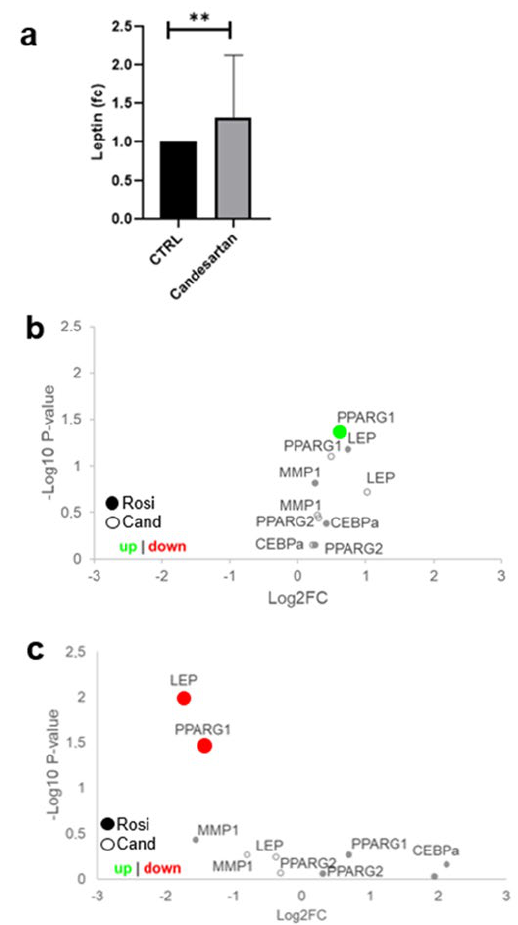
Figure 2. Leptin secretion is upregulated by candesartan in placental explants. ( a ) First-trimester placental villous explants were cultured for 24 h in 0.1 µM candesartan (Cand) and control conditions ( n = 8, isovolumetric control with DMSO). Leptin concentrations were upregulated 1.5-fold (one-sample t -test, p = 0.0025). ( b ) SGHPL-4 cells were treated with 5 µM rosiglitazone or 1 µM candesartan. In qPCR, PPARG1 was upregulated in rosiglitazone-treated cells ( n = 3, Kruskal–Wallis p = 0.0210). ( c ) BeWo cells were treated with 5 µM rosiglitazone (Rosi) or 1 µM candesartan (Cand) for 48 h. qPCR analysis showed that LEP ( n = 3, Unpaired T -test, ** p = 0.0099) and PPARG1 ( n = 3, Unpaired T -test, p = 0.0345) were downregulated in rosiglitazone treated cells.